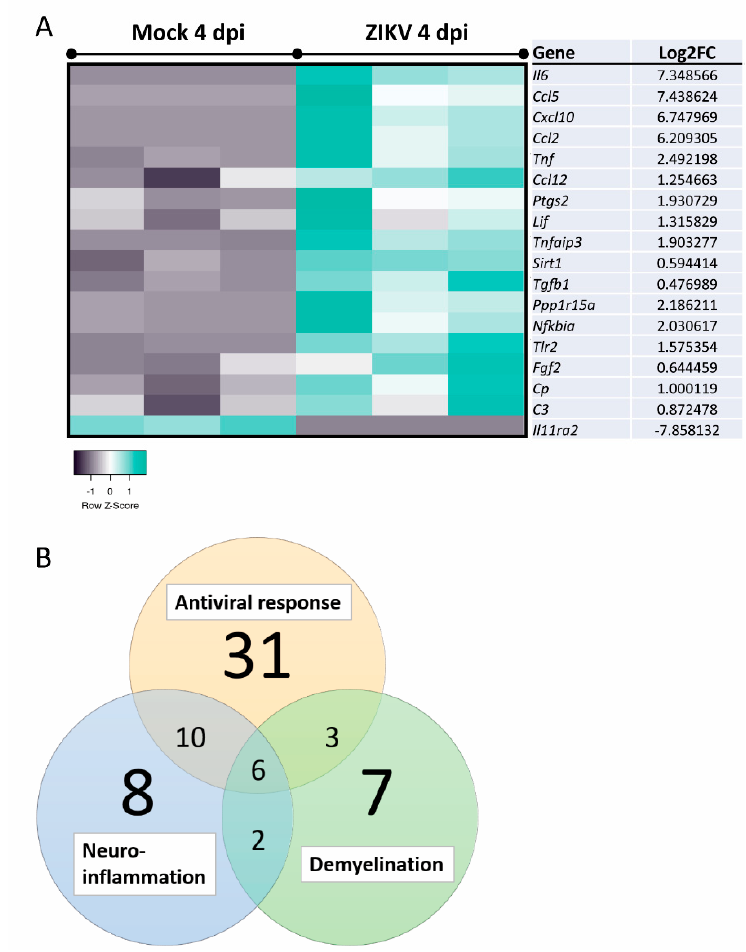
Figure 8. Analysis of DEGs implicated in the demyelination of axons and comparison of DEGs associated with antiviral responses, neuroinflammation, and demyelination. ( A ) Expression analyses of DEGs in ZIKV-infected samples versus mock-infected samples at 4 dpi were performed using IPA and filtered to only include genes involved in demyelination (nervous system tissues, CNS cell lines, and neuroblastoma cell lines). Displayed DEGs were grouped and categorized using the disease and function tool. Log2FC: Log2 fold change expression value. ( B ) Venn diagram of DEGs involved in antiviral response, neuroinflammation, and demyelination. Datasets were compared using VennPlex [84] .